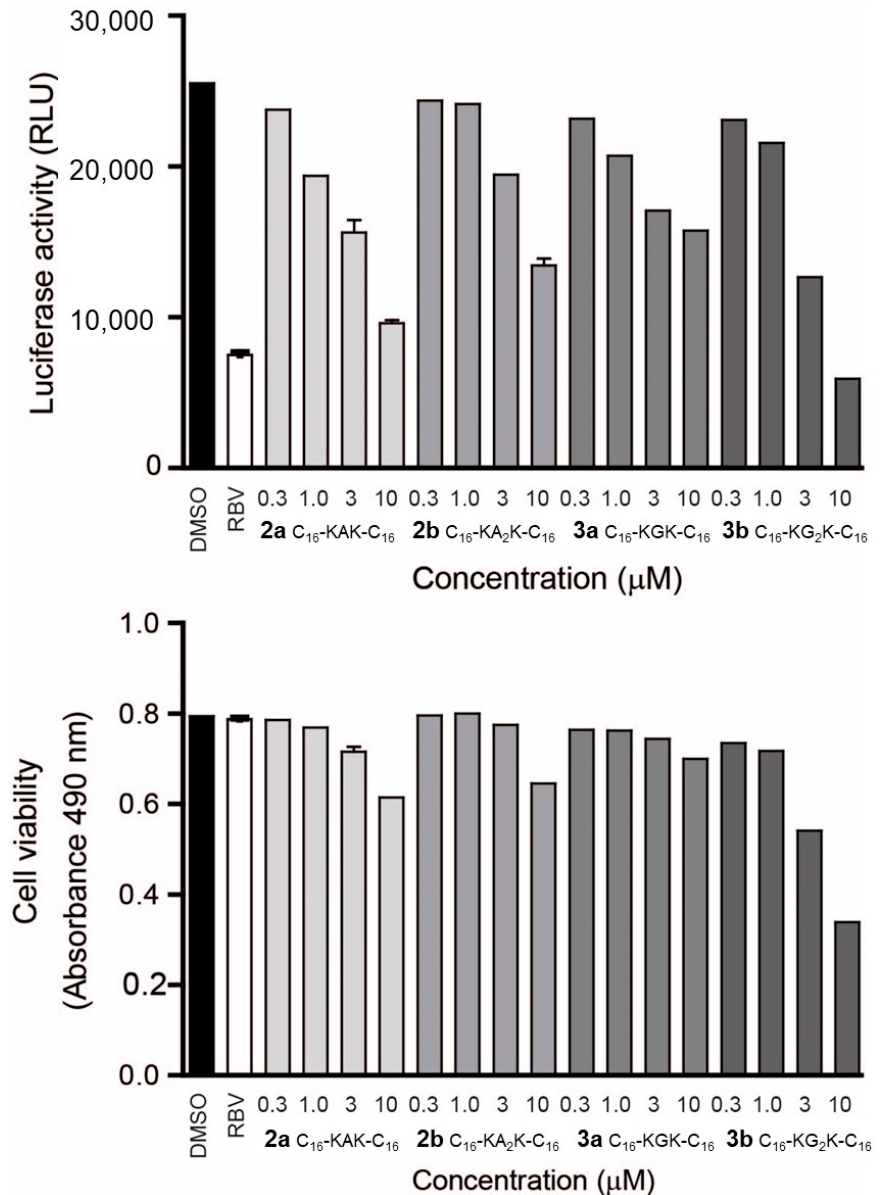
Figure 3. Inhibition of DENV2 replication by geminoids 2a-b and 3a-b . DENV2 HeLa replicon cells were treated for 2 days and luciferase activity ( top panel) and cell viability (MTS assay, absorbance at 490 nm; bottom panel) were assessed. Bars represent means and standard deviation of three biological replicates. DMSO, control with only solvent; RBV, ribavirin (10 µM).